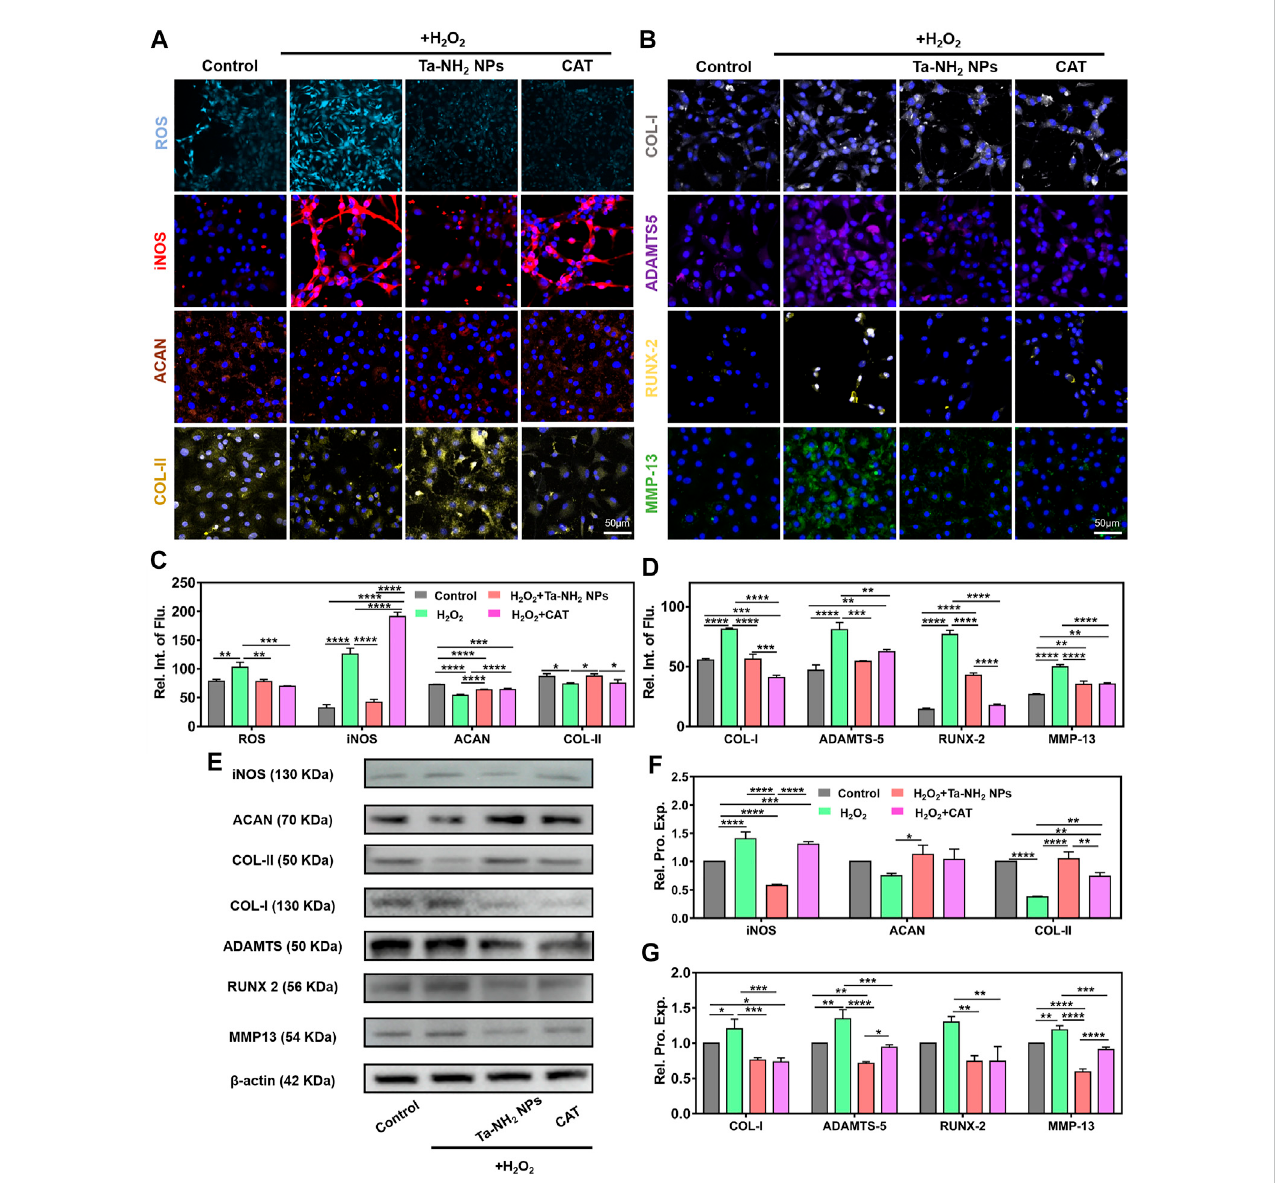
FIGURE 4 Ta-NH 2 NPsandCATreducedoxidativestressandmaintainedthechondrogenicphenotypeofH 2 O 2 -stimulatedchondrocytes.Fluorescencestainingof (A) ROS, iNOS, ACAN and COL-II, (B) COL-I, ADAMTS-5, RUNX-2 and MMP-13 in H 2 O 2 stimulated chondrocytes with or without Ta-NH 2 NPs and CAT pretreatments. (C,D) Quantitative analyses of fl uorescence intensity. (E) Western blot assay of protein expressions in above-described chondrocytes. (F,G) Quantitative analyses of protein expressions. Data were represented as means ± s.d, from three independent replicates. * p < 0.05, ** p < 0.01, *** p < 0.001, **** p <